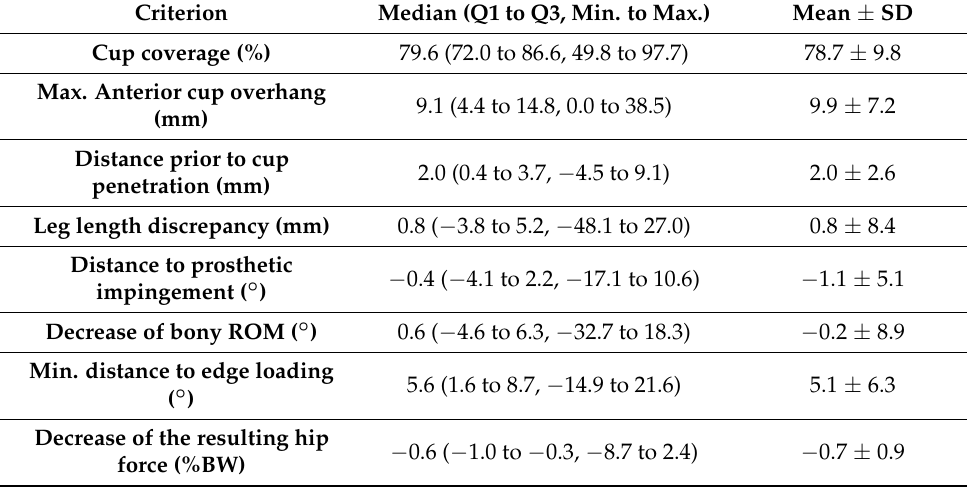
Table 2. Calculated values of each criterion of the PSCTZ.